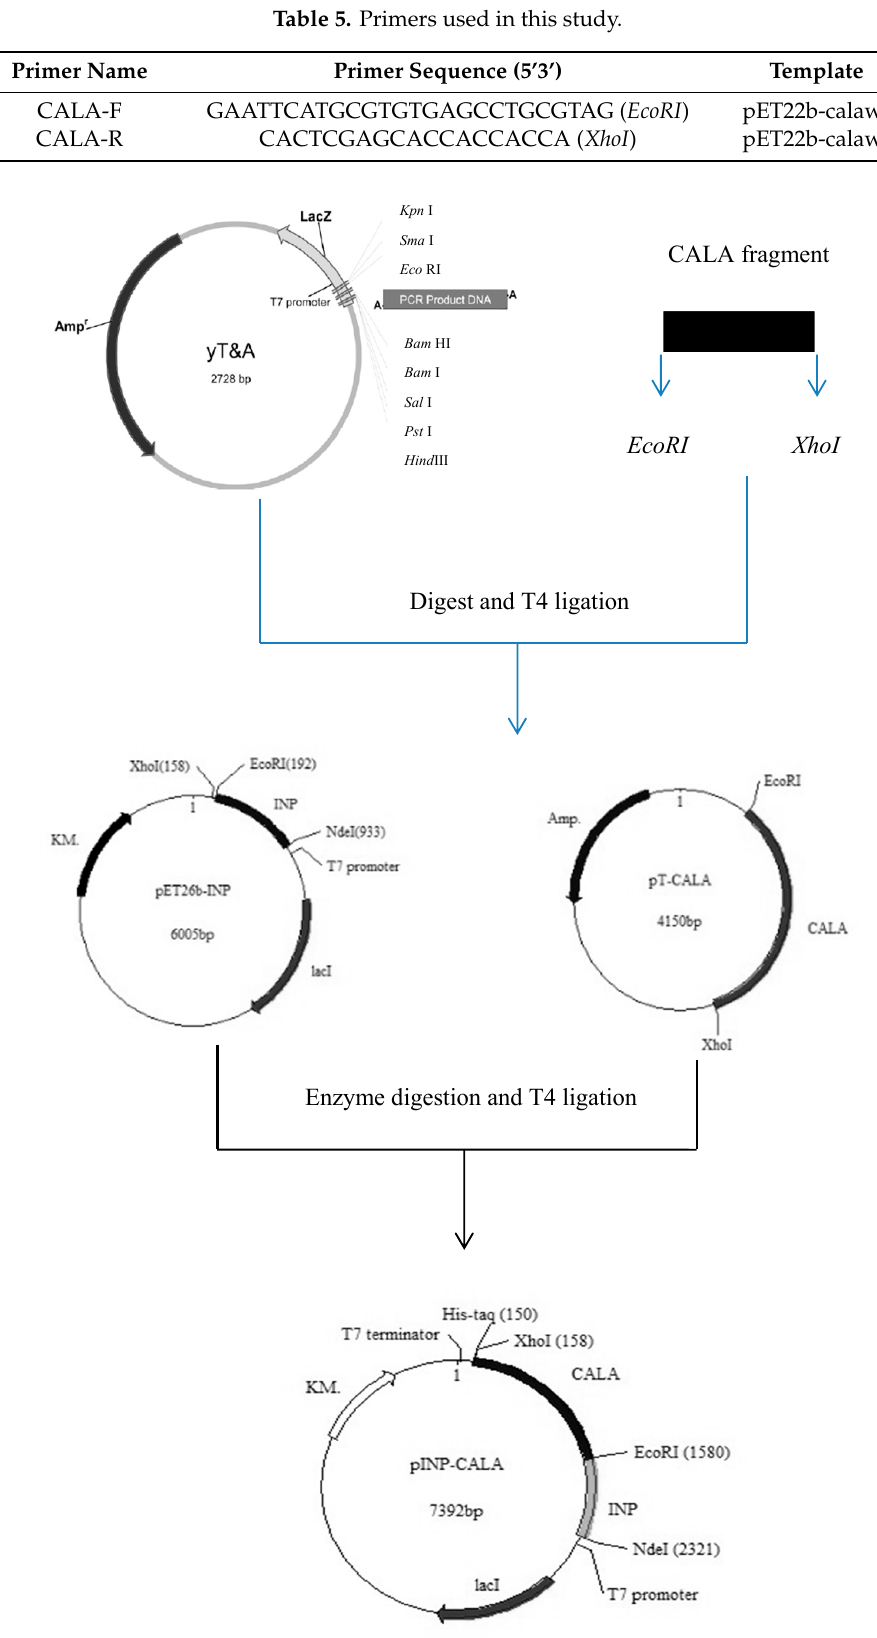
Figure 9. Construction of pINP-CALA.